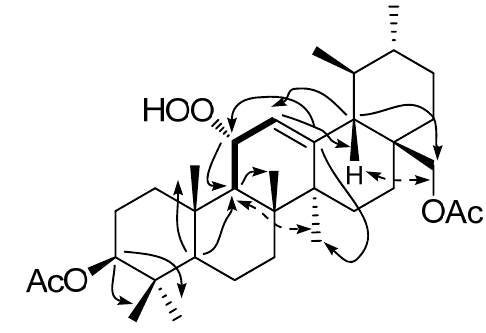
Figure 3. Selected correlations of 3a . Bond bolded indicate COSY, Double-ended arrows indicate NOESY, and single arrows indicate HMBC (C to H) correlations.